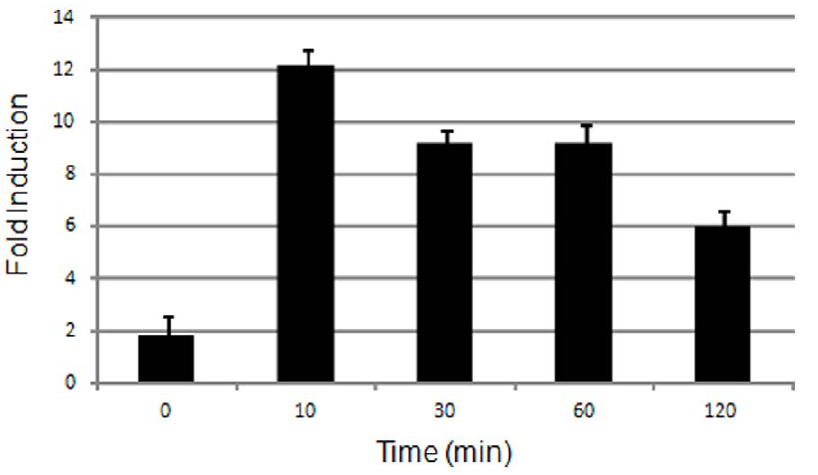
Figure 1. Expression of NTHi fis following nutrient upshift. Quantitative real-time PCR was performed for fis mRNA following nutrient upshift of NTHi wild type strain R2866. The zero time point is fis expression in the stationary phase culture prior to dilution into fresh media, while samples at 10, 30, 60, and 120 minutes indicate fis mRNA levels after nutrient upshift. Each time point included three biological replicates and three technical replicates. Error bars are standard